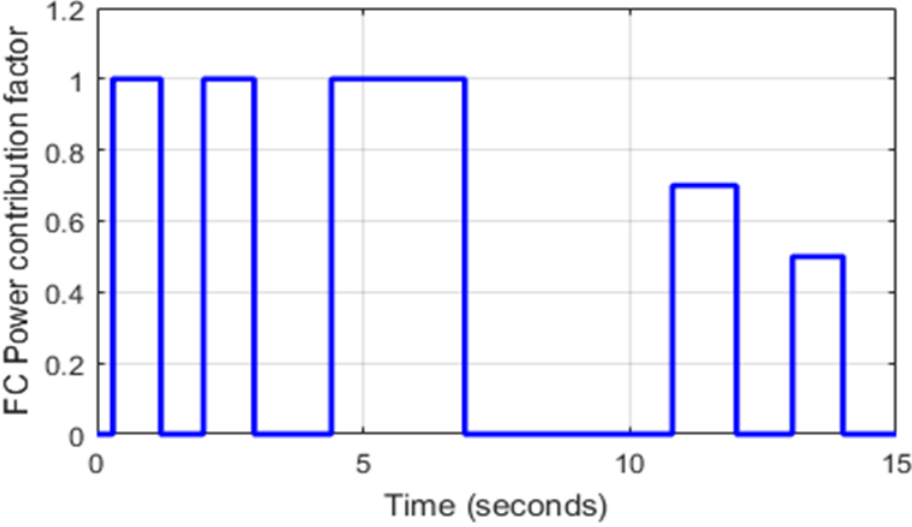
Figure 13. FC power contribution factor.